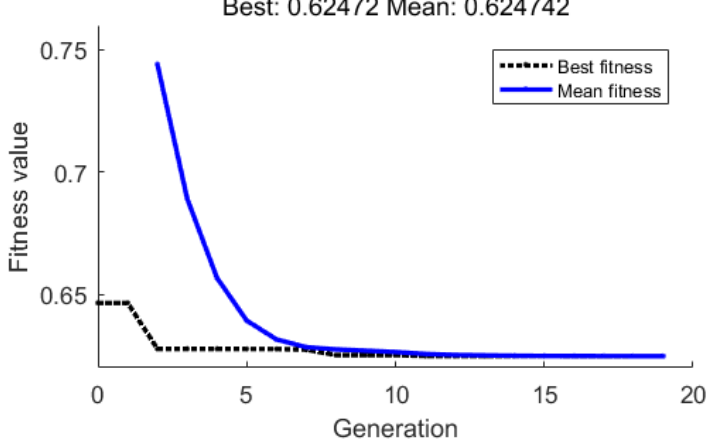
Figure 5. Change in the objective in terms of average and best values with the generation.